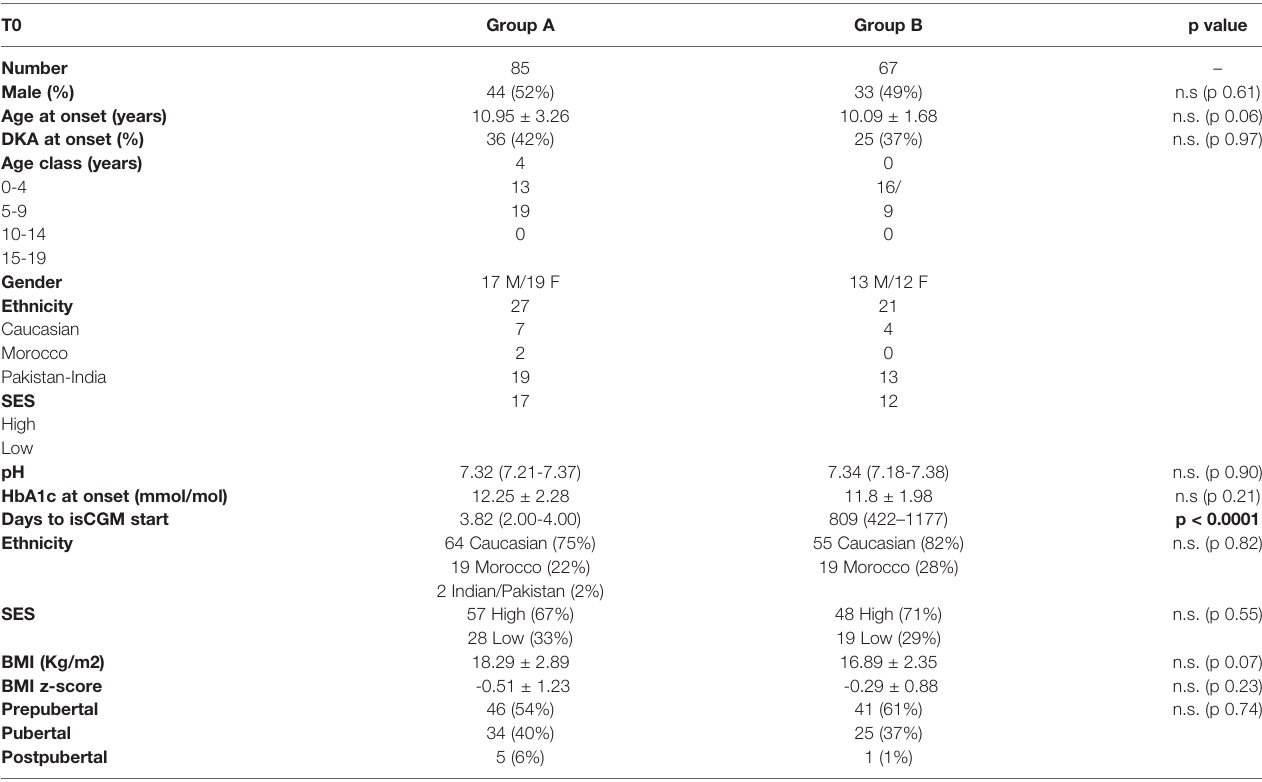
TABLE 1 | Population characteristic at the T1D onset